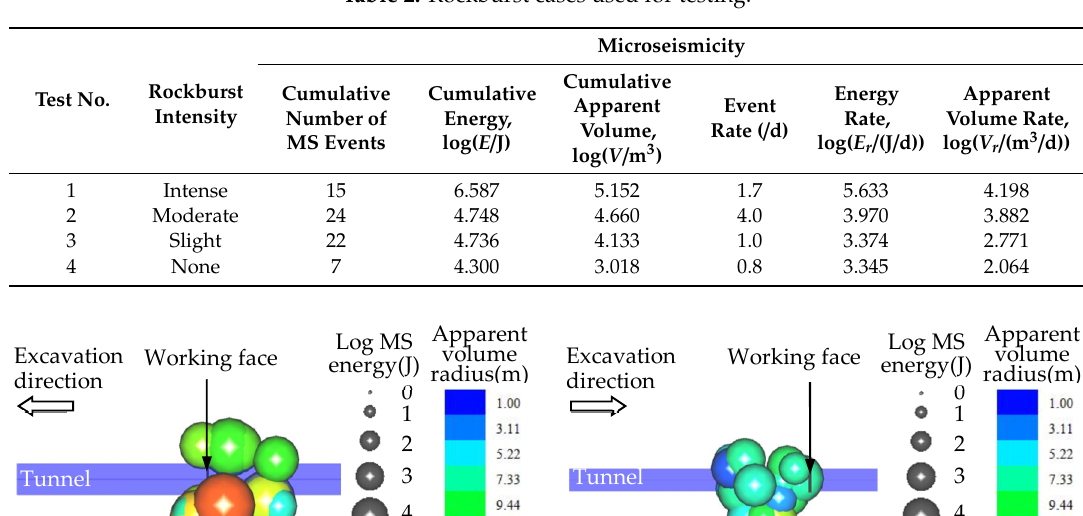
Table 2. Rockburst cases used for testing.